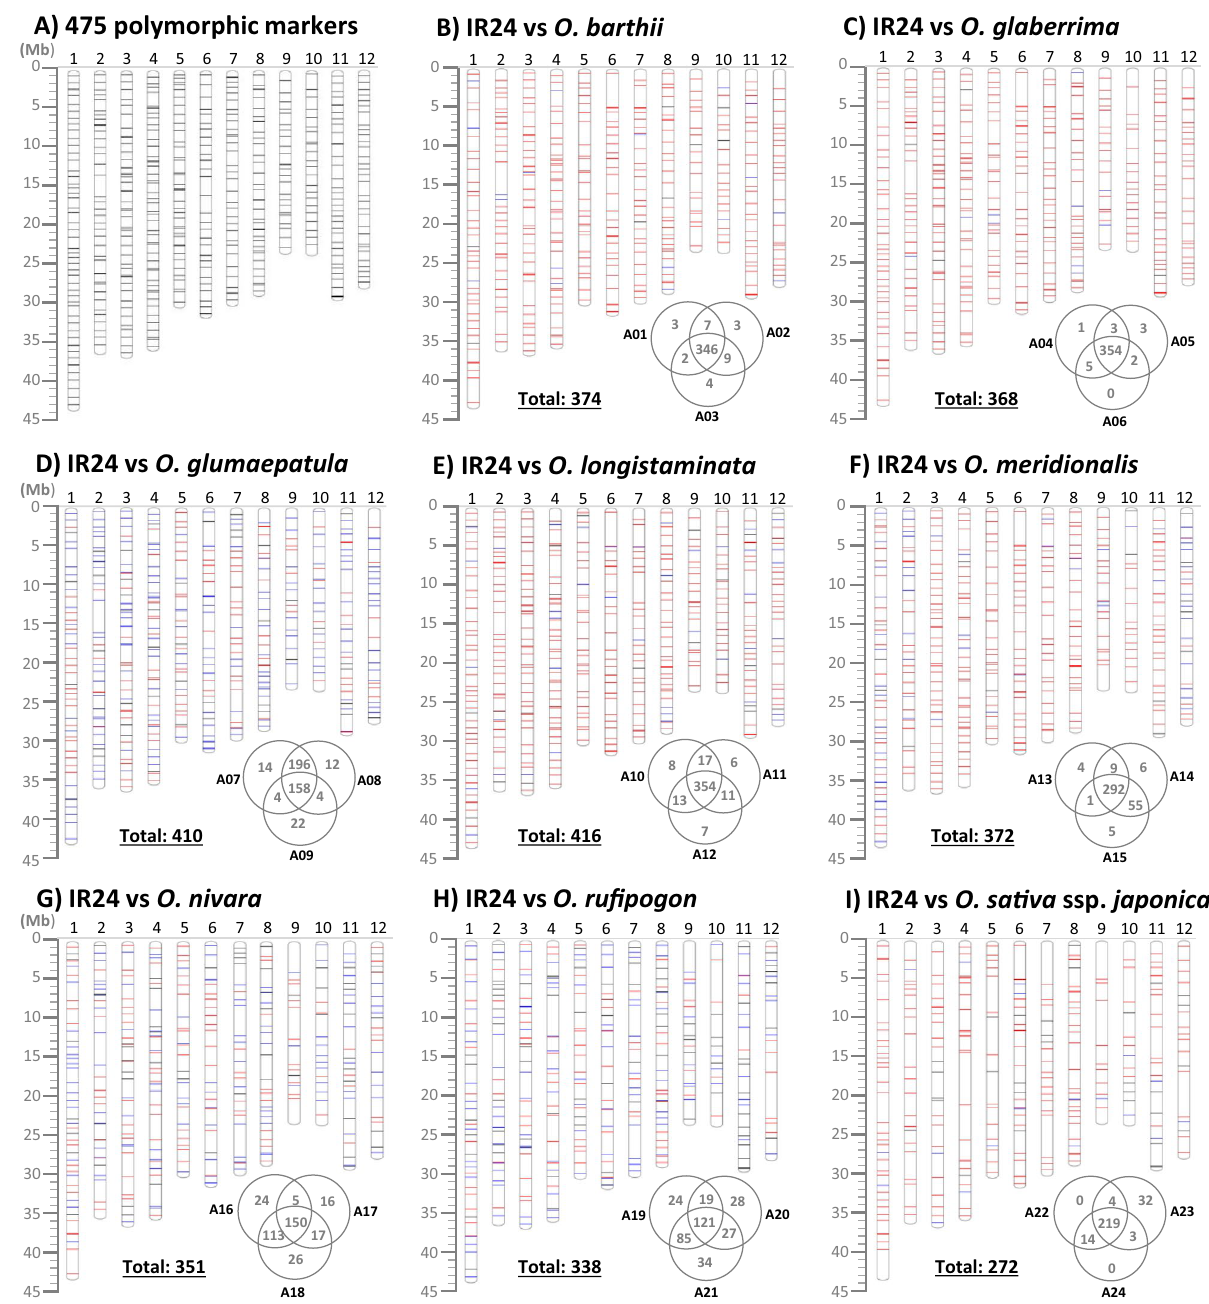
Figure 3. Physical locations of the polymorphic markers. The position of each marker was mapped on the rice reference genome (Os-Nipponbare-Reference-IRGSP-1.0) with a horizontal bar. ( A ) All available 475 polymorphic markers between O. sativa and the other AA-genome species. The selected polymorphic markers showing polymorphism between IR24 and O. barthii ( B ), O. glaberrima ( C ), O. glumaepatula ( D ), O. longistaminata ( E ), O. meridionalis ( F ), O. nivara ( G ), O. rufipogon ( H ), and O. sativa subsp. japonica ( I ), respectively. Within a species, the common polymorphic markers among three accessions and between two accessions are highlighted by red and blue bars, respectively, and the accession-specific polymorphic markers are depicted with a black